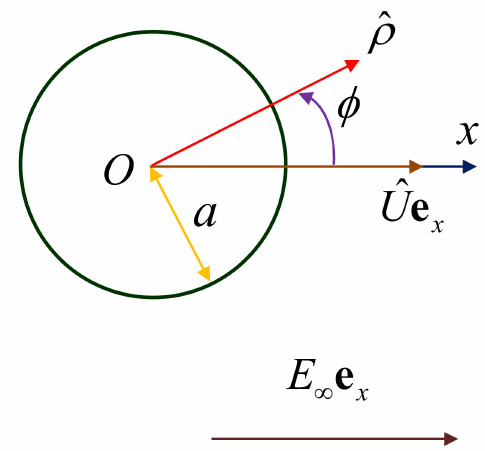
Figure 1. Geometrical sketch for the di ff usiophoresis of a circular cylindrical particle in a transverse